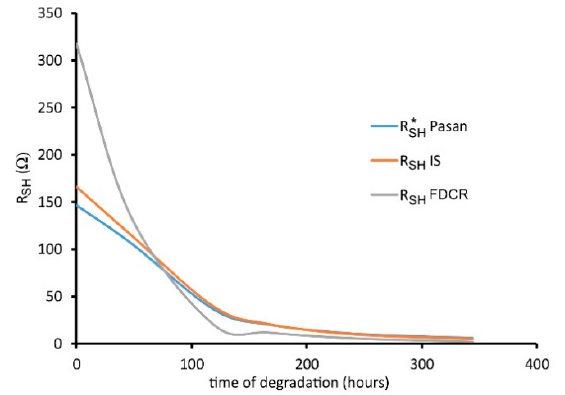
Figure 12. Change measured R SH of PV module due to PID.